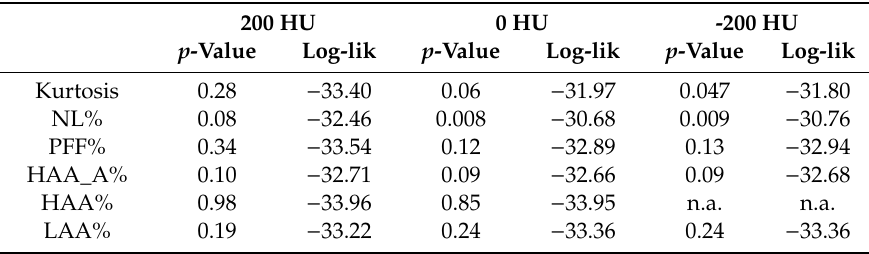
Table 5. Poisson models were fitted over HRCT data, using the Gender-Age-Physiology (GAP) index as a response variable, and each of the HRCT measures at di ff erent thresholds as explanatory variables. 200 HU 0 HU -200 HU p -Value Log-lik p -Value